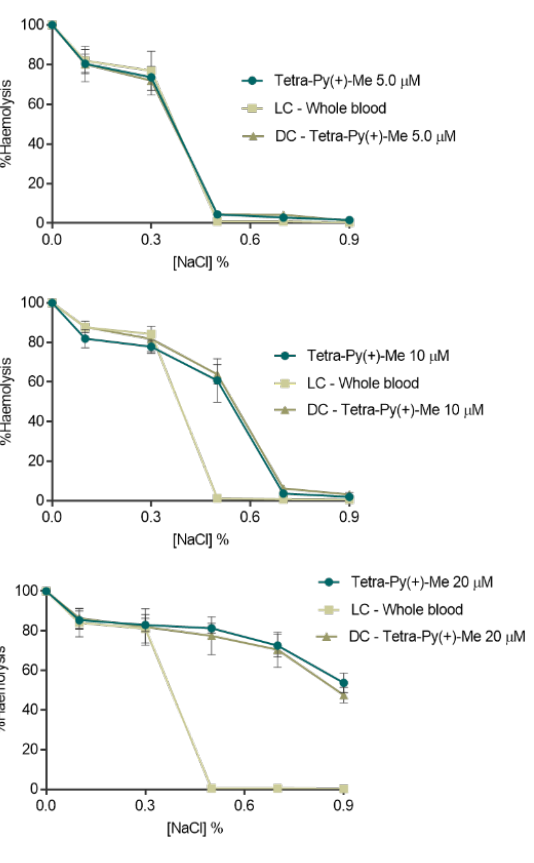
Figure 2. Erythrocyte osmotic fragility before and after aPDT treatment with Tetra-Py(+)-Me (5.0, 10 and 20 µM) and under white light irradiation at an irradiance of 150 mW·cm − 2 . All values represent the average of three independent assays. Error bars indicate the standard deviation and in some cases are collapsed with the symbols. LC—Light control (whole blood under light); DC—Dark control (whole blood incubated with PS without light).